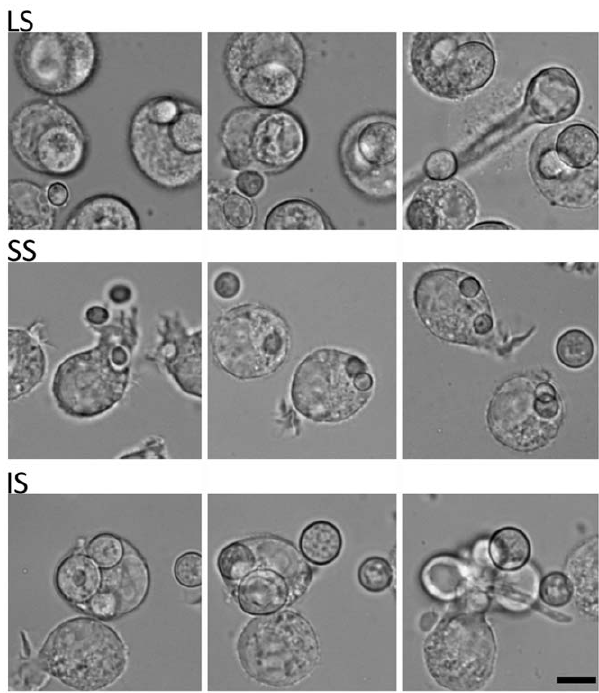
Figure 3. Time-lapse analysis of response of the murine macrophage to large spores (LS), small spores (SS), and isotropically grown spores (IS). The macrophage (J774) engulfs each of the different-sized spores successfully. Both LS and IS germinate inside macrophages indicating that their invasive hyphal growth is not inhibited by the macrophage. In contrast, SS are trapped inside the macrophage and either do not undergo isotropic growth or exhibit very limited growth when compared to the spores outside of the macrophage that grow isotropically. Time progresses across each row in the images from left to